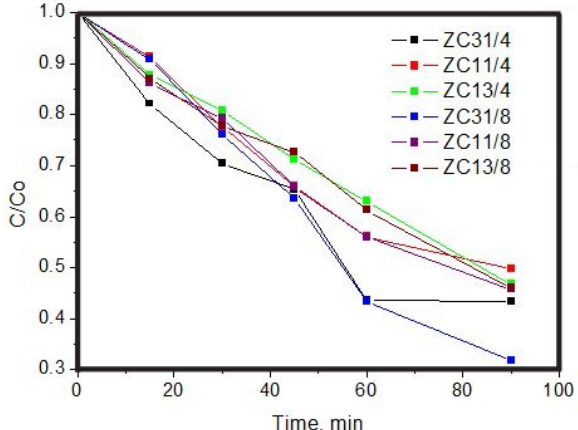
Figure 7. Photocatalytic degradation of Malachite Green by the samples ZC31/4, ZC11/4, ZC13/4, ZC31/8, ZC11/8, ZC13/8 under UV-irradiation